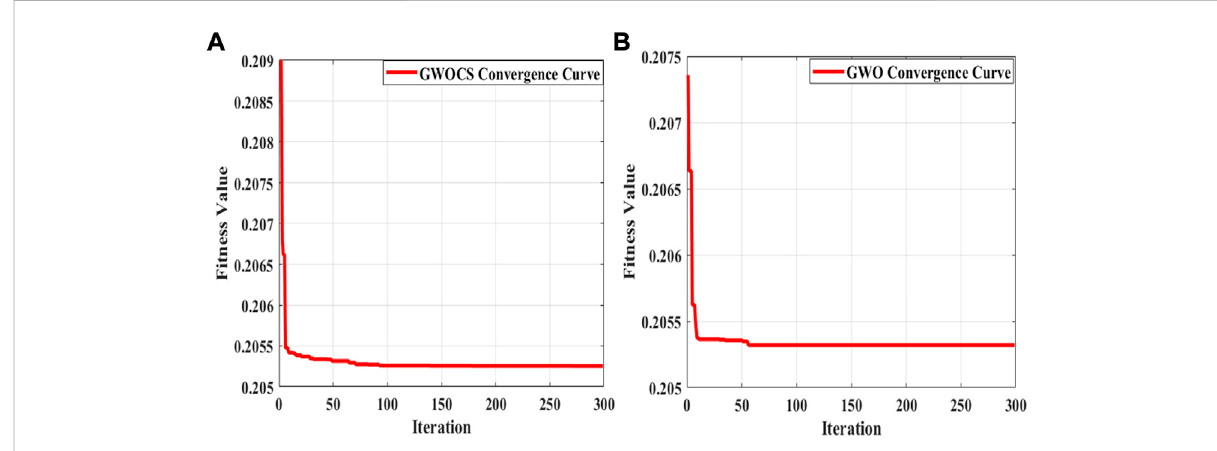
FIGURE 7 The convergence curve of (A) GWCSO and (B) GWO.